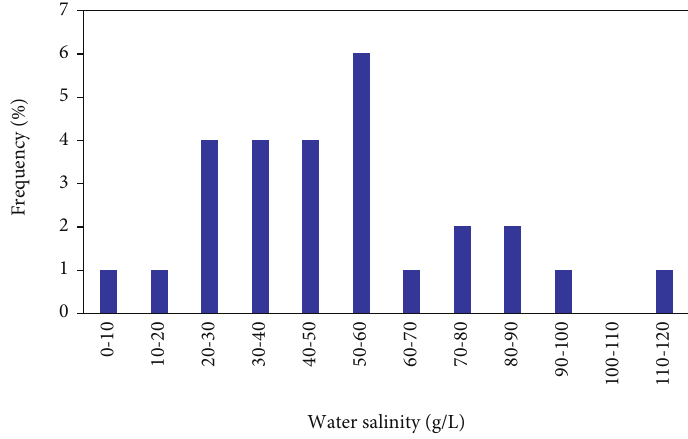
Figure 3: Histogram of the formation water salinity distribution.